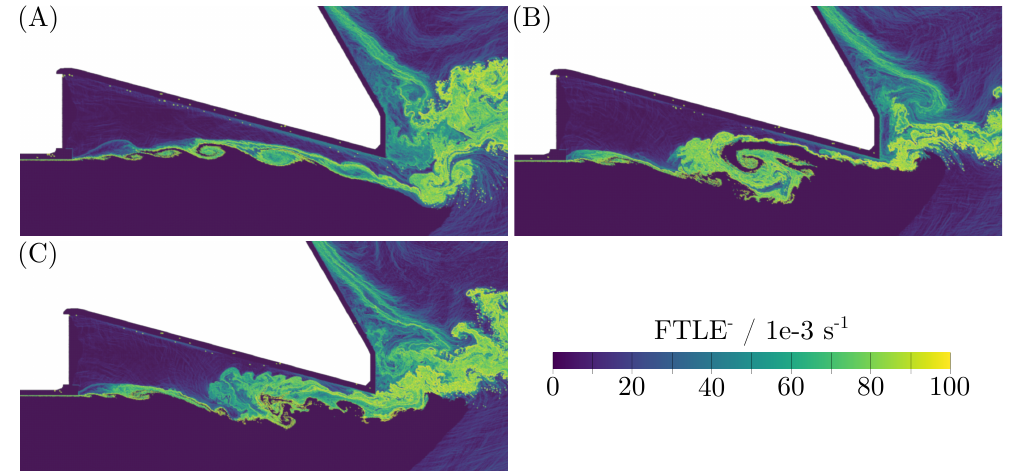
Figure 6. Instantaneous FTLE − fields. FTLE − : Backward in time Finite-Time Lyapunov Exponent. ( A ): Balanced Condition t 0 ; ( B ): Vortex Formation t 1 ; ( C ): Flow Reversal t 2